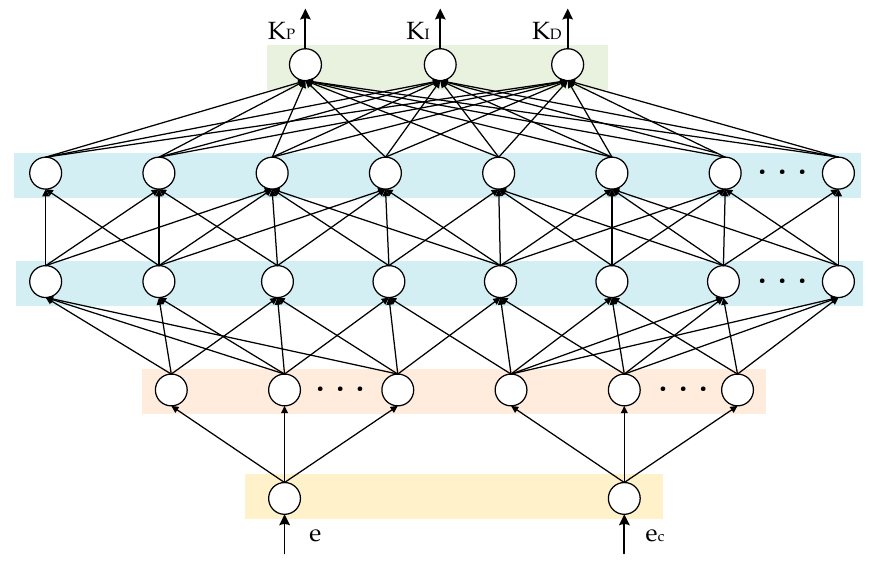
Figure 3. FNN structure model.